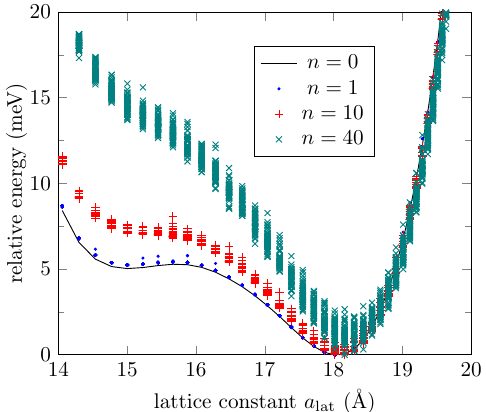
Figure 7. Energy distribution, according to the ML potential, of a pristine 401-AGONR ( n = 0), and in the presence of n = 1,10,40 vacancies out of 400 oxygen atoms at random positions. Fifty samples are collected for each lattice constant and for each n